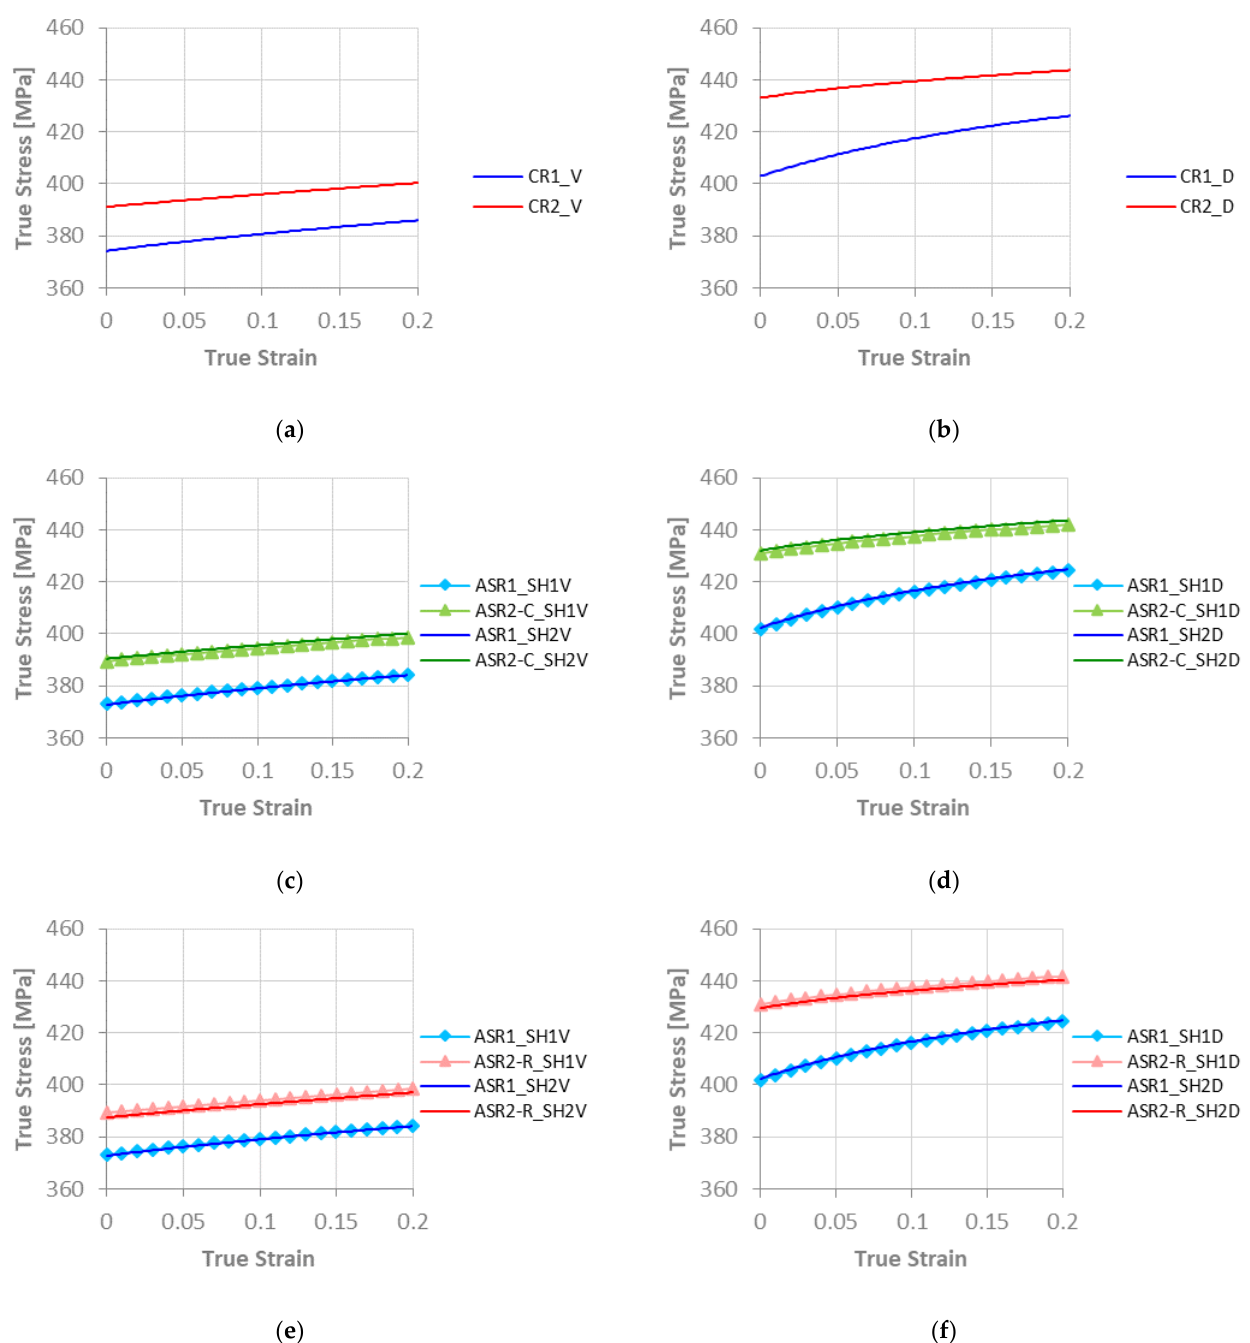
Figure 10. Stress – strain curves of two-pass sequences rolling with a 30% reduction per pass, considering two different shear strain values, (SH1) and (SH2), for: ( a ) conventional rolling with a Voce-type hardening law (V); ( b ) conventional rolling with DDR model (D); ( c ) asymmetric-continuous rolling with a Voce-type hardening law; ( d ) asymmetric-continuous rolling with DDR model; ( e ) asymmetric-reverse rolling with a Voce-type hardening law; and ( f ) asymmetric-reverse rolling with DDR model, simulation.